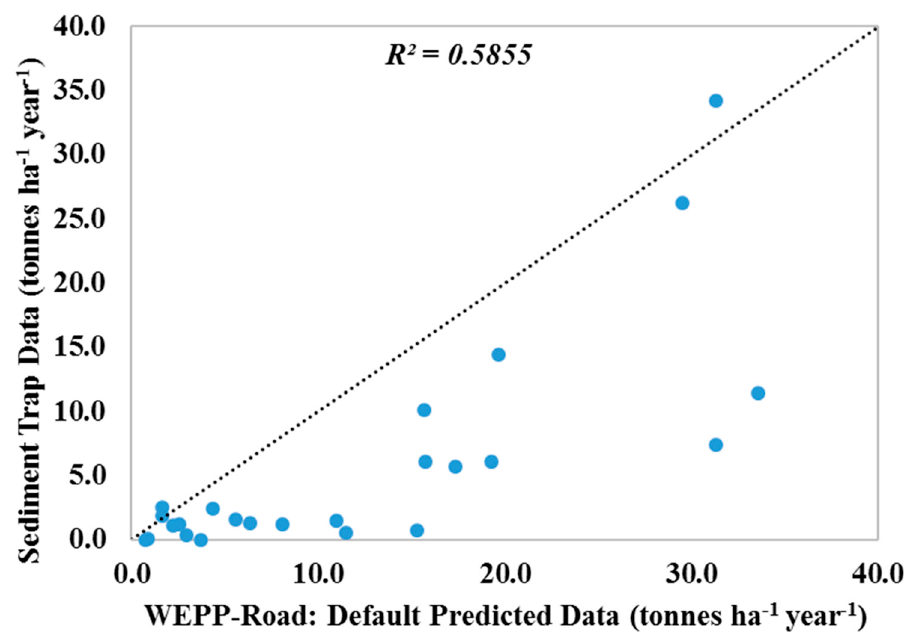
Figure 7. Linear relationship of WEPP-Road modeled data and actual measured erosion data. Line on graph represents a 1:1 relationship.